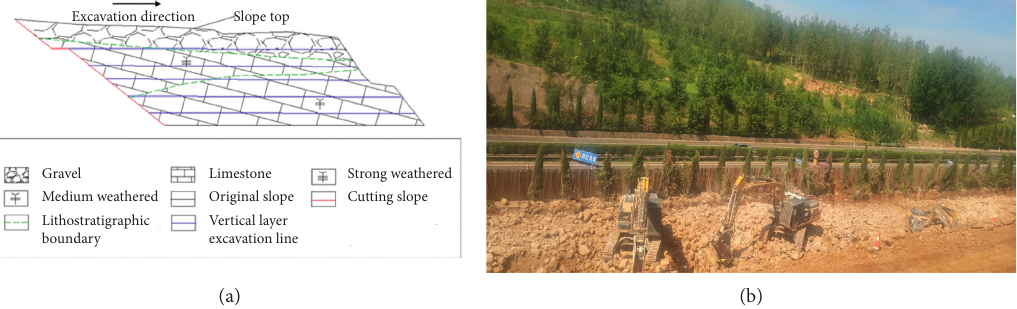
Figure 2: Scheme of mechanical excavation in K503 +585 ∼ 504+ 018 slope. (a) Schematic of the road excavation; (b) mechanical excavation on site.